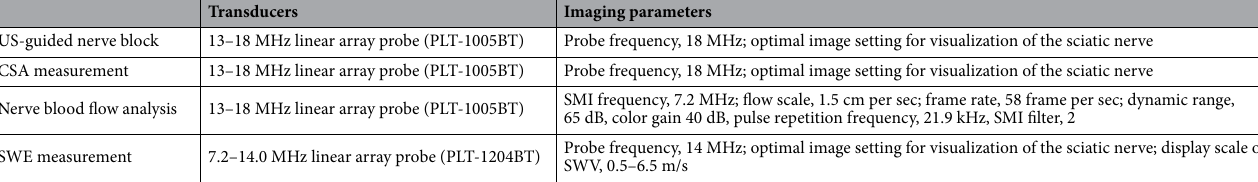
Table 1. The transducers and imaging parameters for US-guided nerve block and US measurements. CSA cross-sectional area, SMI superb microvascular imaging, SWE shear wave elastography, SWV shear wave